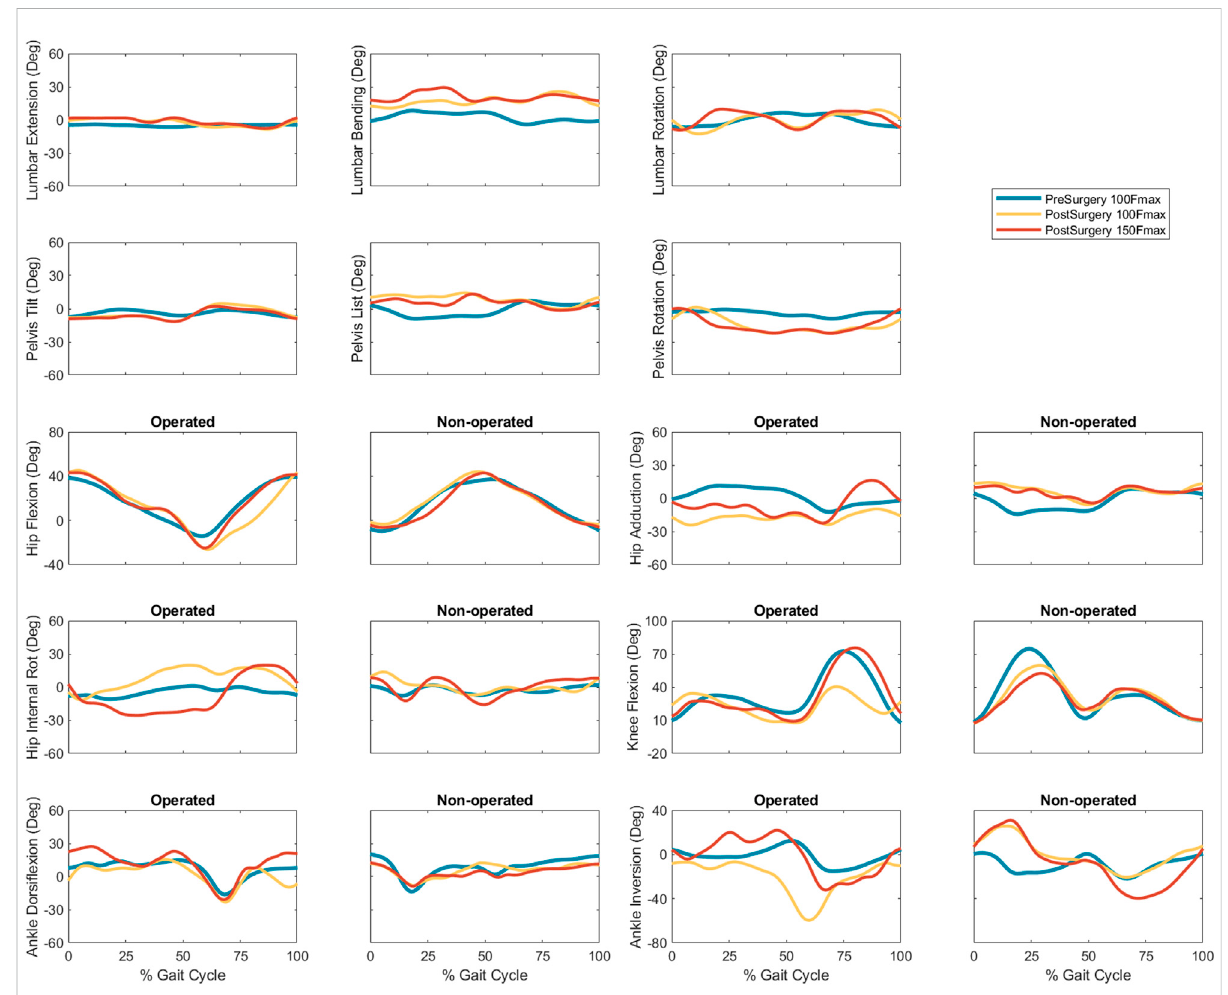
FIGURE 5 Experimentalpre-surgeryandpredictedpost-surgeryjointanglesforpost-surgerypsoasstrengthsof100%,and150%ofthepre-surgeryvalue. The gait cycle begins with operated leg heel